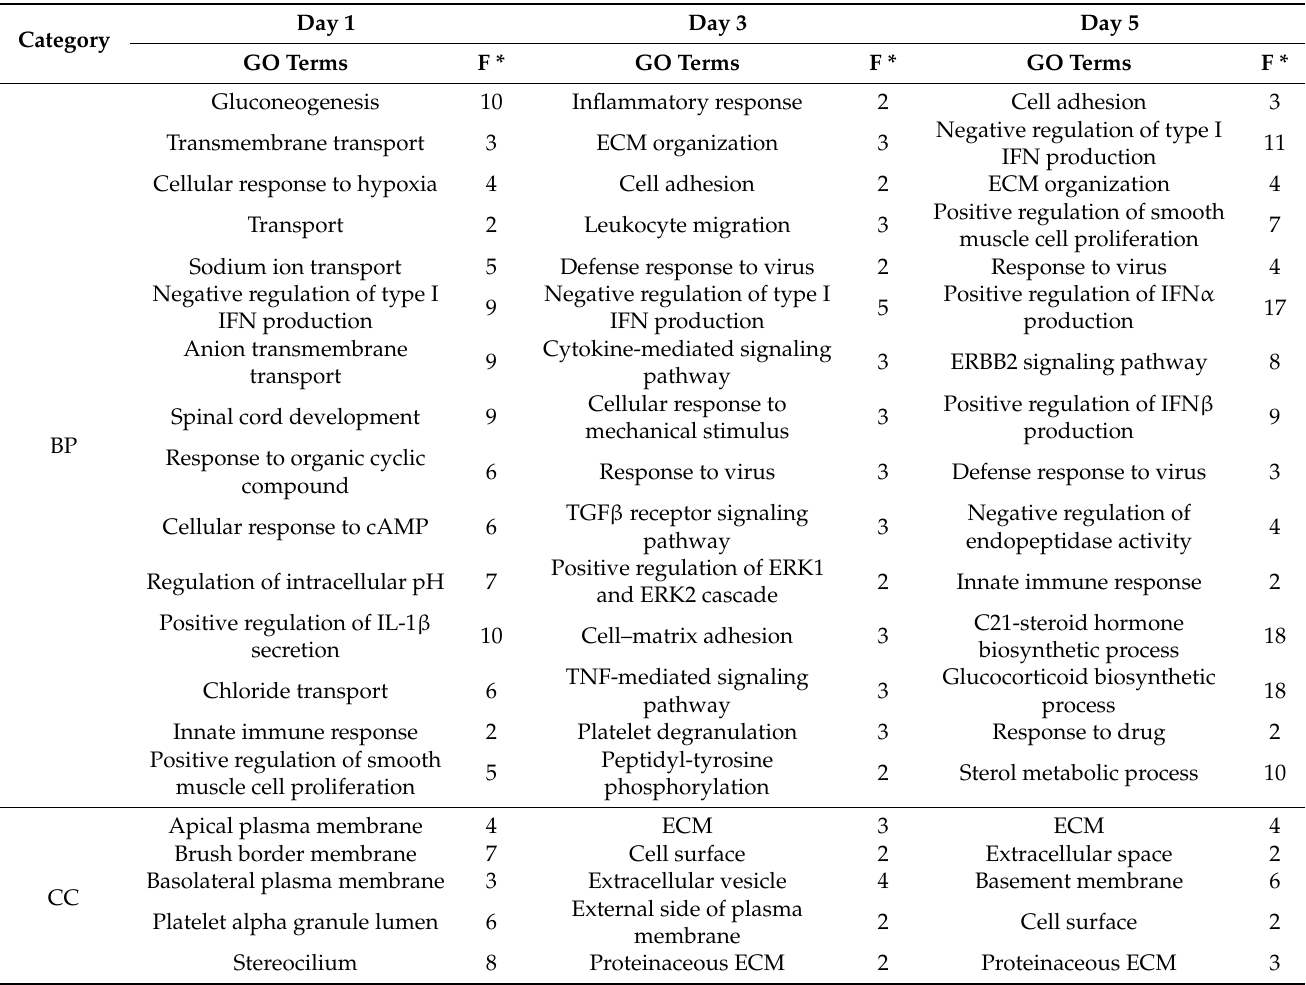
Table 3. Top GO terms identified at each point in IHNV-infected